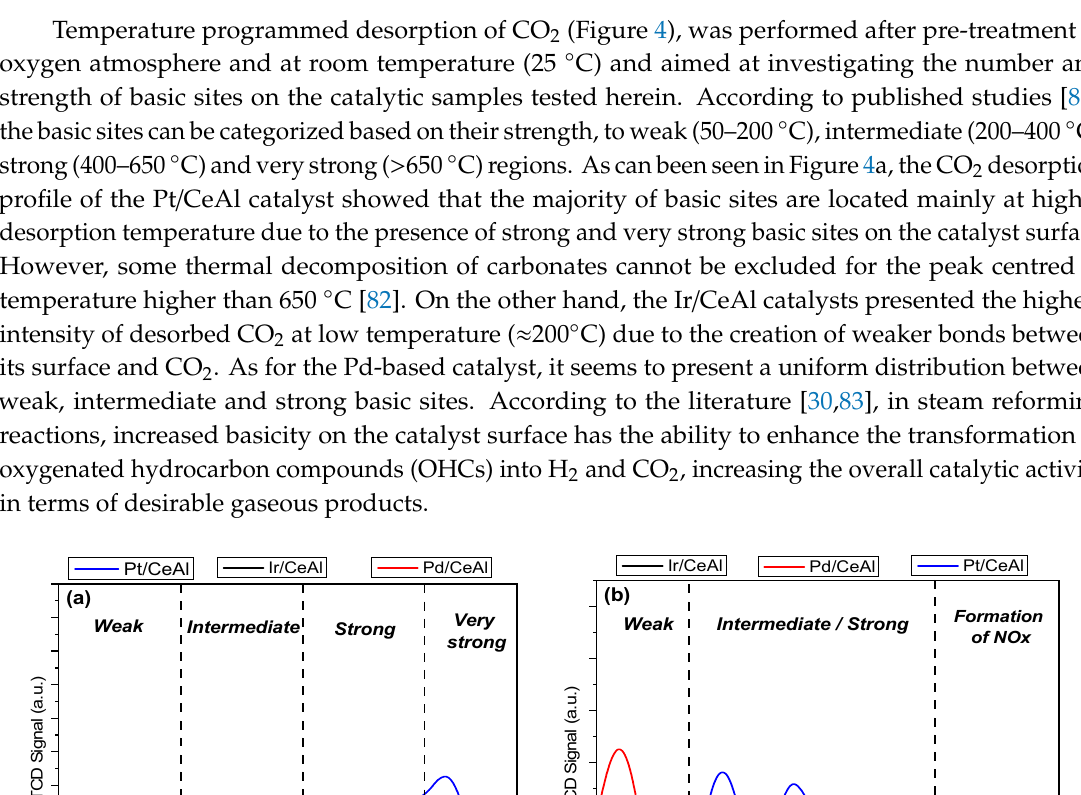
Figure 3. H 2 –TPR profiles of the calcined Ir/CeAl, Pd/CeAl and Pt/CeAl catalysts.